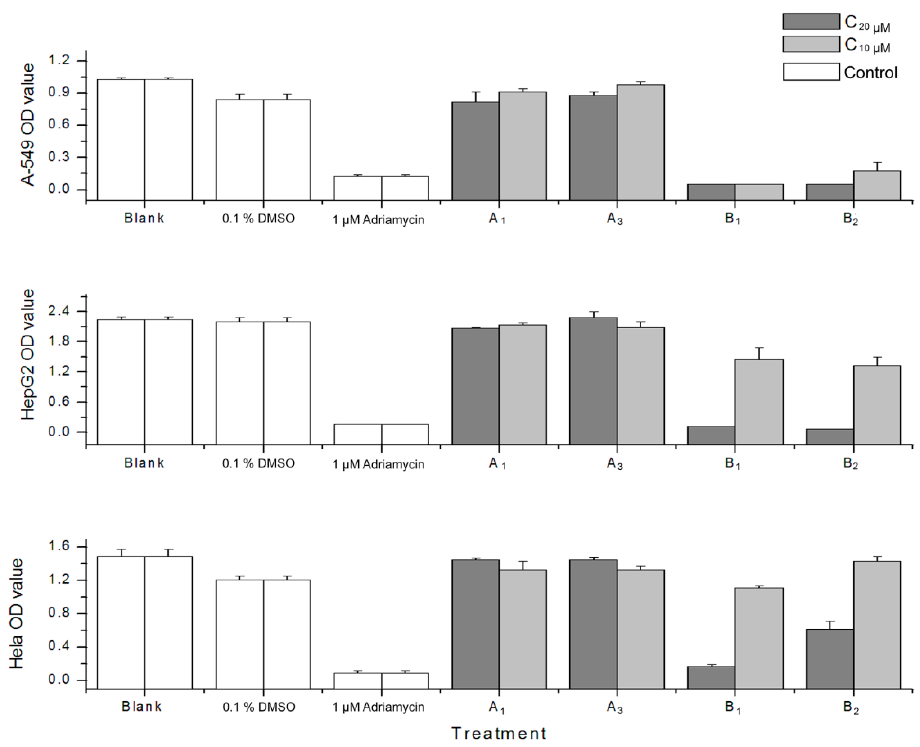
Figure 3. The effect of compounds on tumour cells proliferation. A 1 : Oleiferasaponin A 1 ; A 3 : Oleiferasaponin A 3 ; B 1 : Camelliasaponin B 1 ; B 2 : Camelliasaponin B 2 .